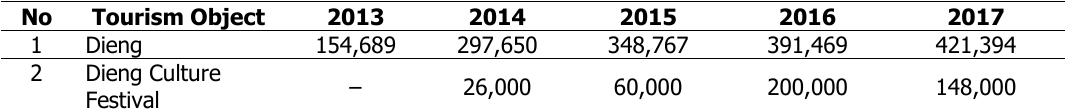
Table 1. The tourist arrivals number in Dieng Year of